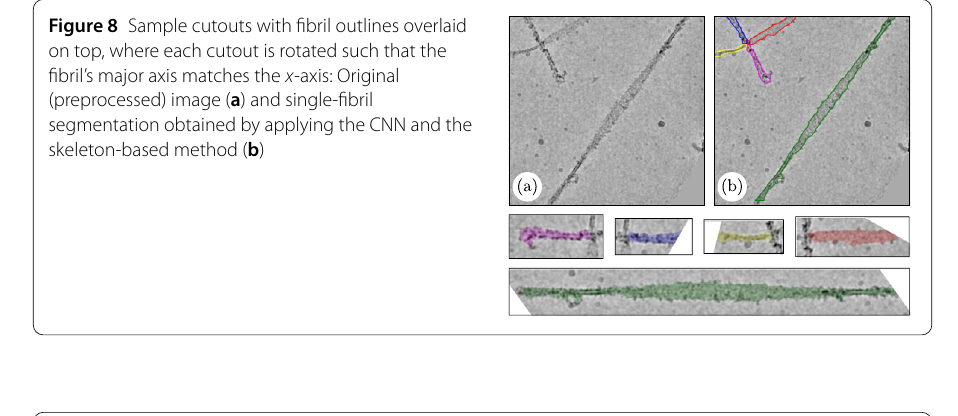
Figure 9 Scatterplot of manually measured widths ( x -axis) and automatically determined widths ( y -axis). The red line indicates the diagonal. Histograms of both variables are shown on the